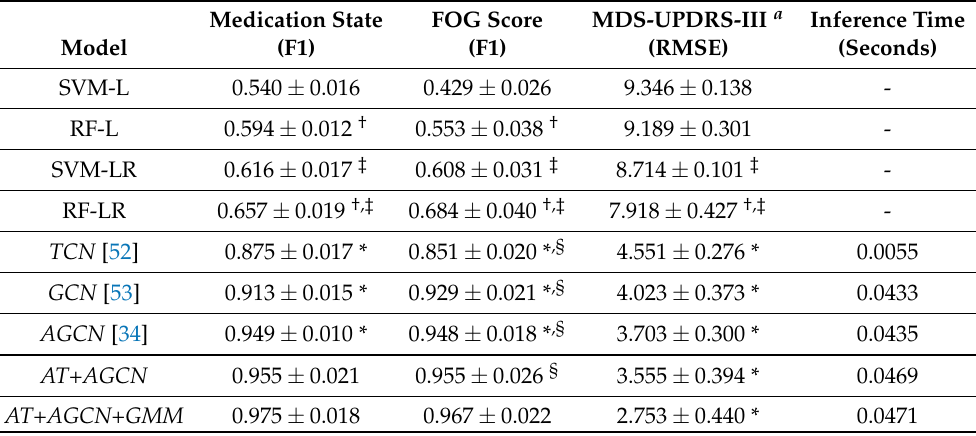
Table 3. Prediction performance of the proposed model (AT+AGCN+GMM) and comparison to baseline models. We also compare the run time of each deep learning model used in the experiment. Performance metrics are presented as mean ± 95% confidence interval. Deep learning models are indicated by italics. Abbreviations are described in text. a Total score with FOG item (3.11) subtracted. † p < 0.05, improvement in RF vs. SVM. ‡ p < 0.05, improvement in -LR vs. -L. * p < 0.05, improvement in deep learning models vs. preceding row. § p < 0.05, improvement in multi-task vs. single task prediction.